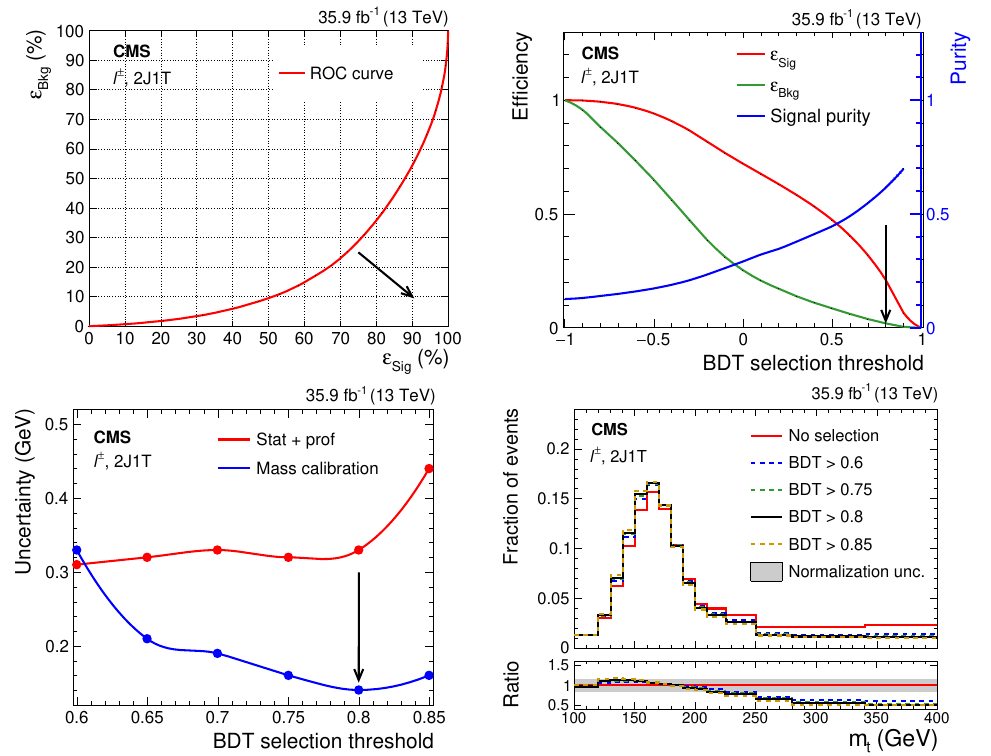
Figure 5 . Combined BDT performance in terms of the ROC curve (upper left), and the signal and background efficiencies and signal purity as functions of the BDT selection threshold (upper right) in the muon and electron final states. The uncertainty in m from the combined statistical t and profiled systematic components (red curve), and from the mass calibration (blue curve) as a function of the BDT selection threshold (lower left). Arrows on the plots indicate the region of better separation (upper left) and optimized selection criteria (upper right and lower left). A comparison of the reconstructed m shapes from simulated signal events for different selection thresholds on t the BDT response is shown on the lower right. The lower panel shows the ratio relative to the case where no selection (red) is applied, with the grey band denoting the normalization uncertainty around the red